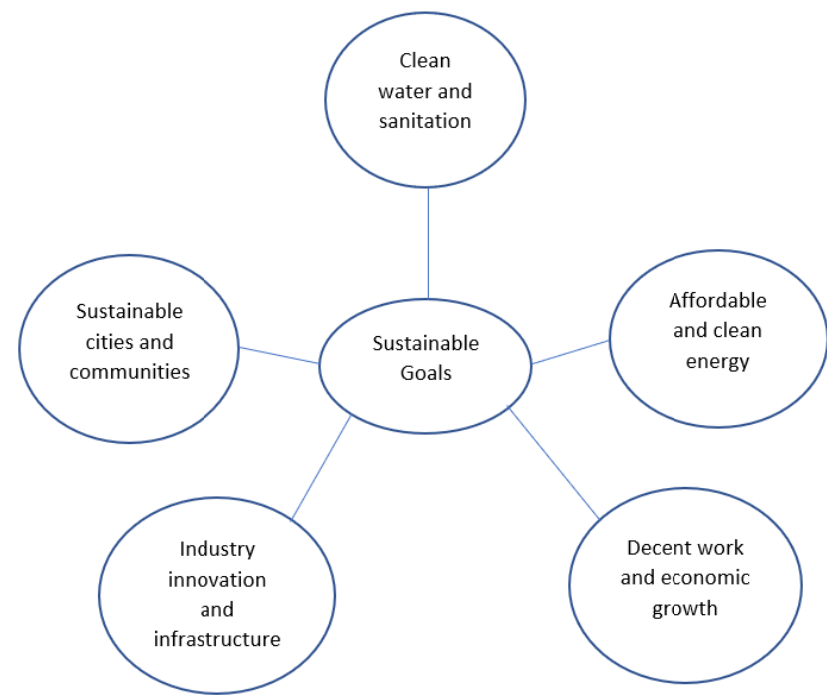
Figure 1. Vision 2030 projects Goals.